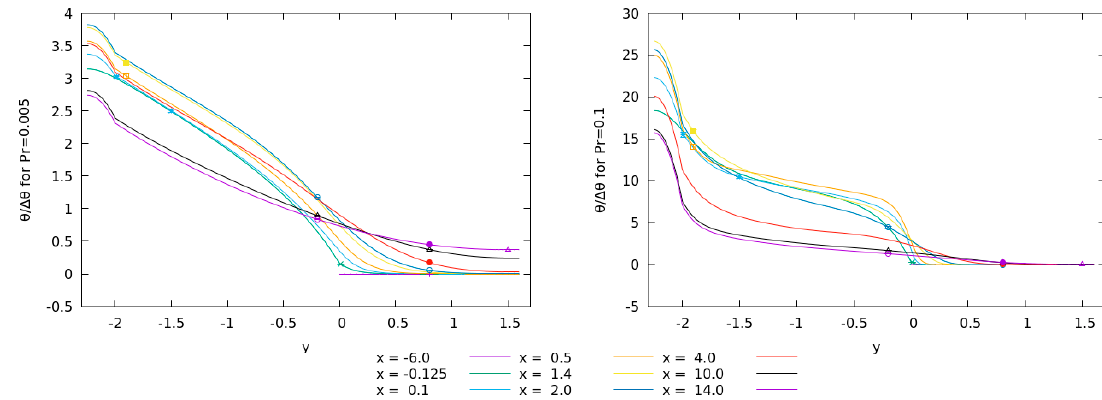
Figure 6. Passive scalar profiles together with monitor point data uncertainties at specific positions in the plane 𝑧 = 0 .